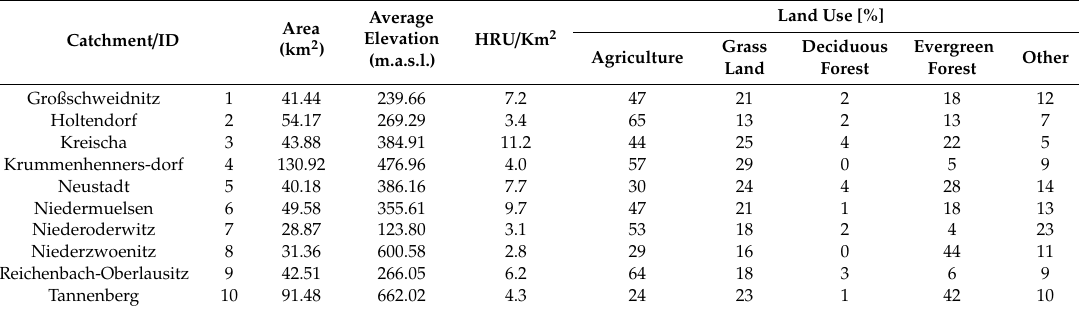
Table 1. Summary of important characteristics of selected